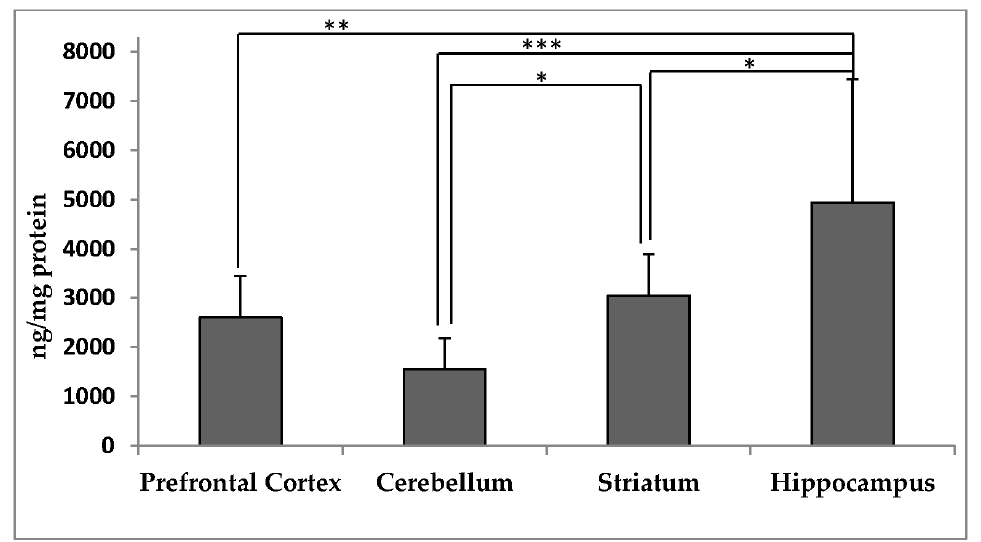
Figure 1. α -Tocopherol concentrations (ng/mg protein, mean ± SD) in different regions of the brain from adult rhesus macaques ( n = 9). Asterisks indicate significant differences between brain regions according to one-way analysis of variance (ANOVA) followed by Tukey’s honest significance difference (HSD) test; * p < 0.05, ** p < 0.01, *** p < 0.001.